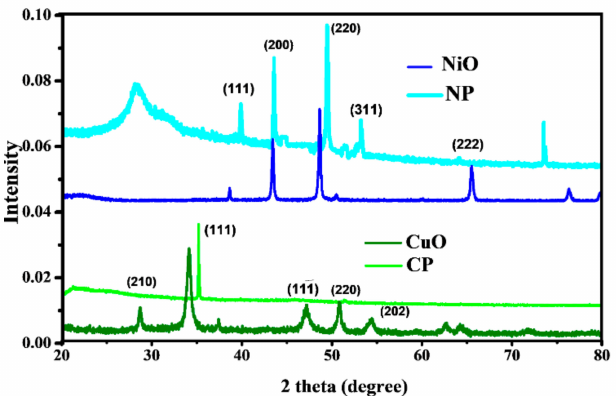
Figure 3. X-Ray powder diffractograms, pure NiO nano-powder and PVA/NiO(NP3) thin film, pure CuO nano-powder and PVA/CuO (CP3) thin film within 10 ◦ < 2 θ > 80 ◦ at room